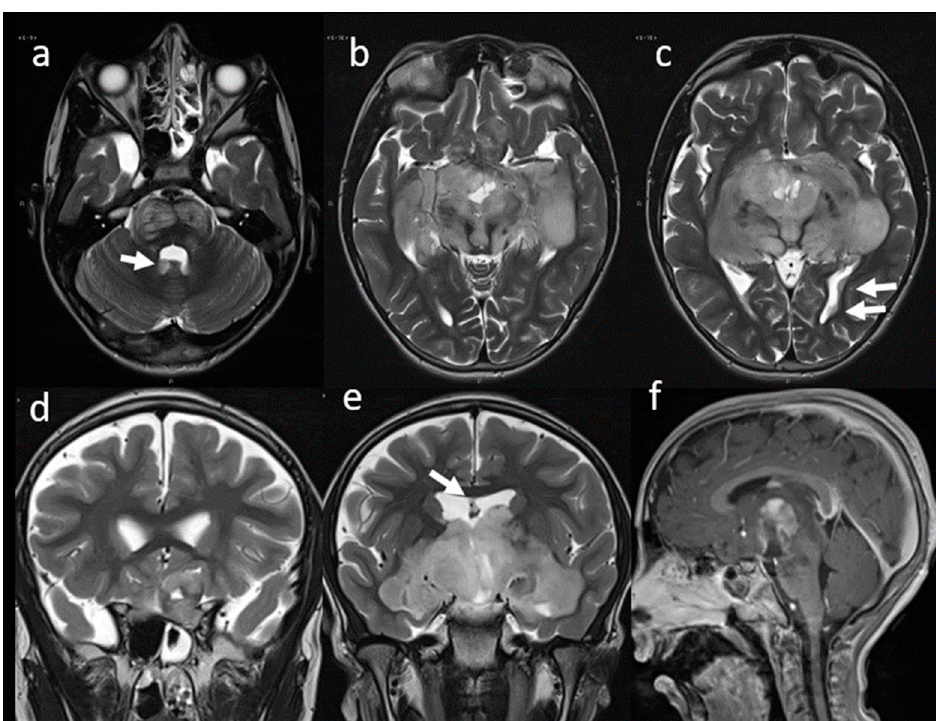
Figure 2. MRI. T2w axial ( a – c ) and coronal ( d , e ) images at the time of disease progression. Signal characteristics appear essentially unchanged. Multiple secondary localizations along the ventricular profiles are also well evident (arrows). Sagittal Gd T1w ( f ) image shows partial reduction of the inhomogeneous contrast enhancement of the suprasellar